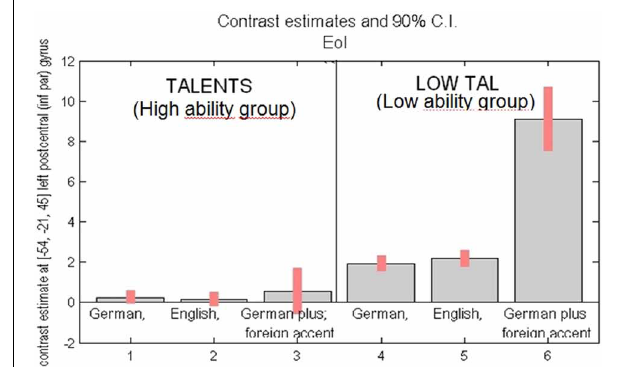
FIGURE 7 | Activation intensity as given by percent BOLD (blood oxygen level dependent) signal change (y-axis) in the peak